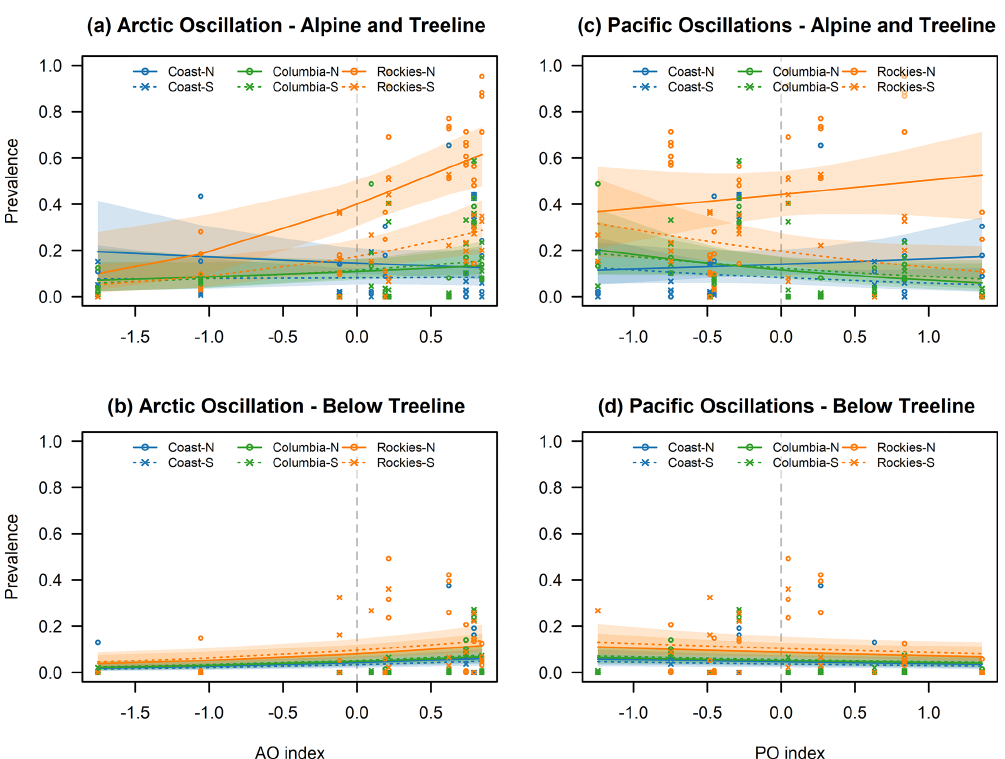
Figure 8. Calculated prevalence for deep persistent slab avalanche problems in relation to AO (a, c) and Pacific-centered oscillations (c, d) for the alpine/treeline (a, c) and below treeline (b, d) over the range of observed index values. Lines indicate the mean estimates, and shaded areas represent the 95% confidence intervals. Individual points represent observed prevalence